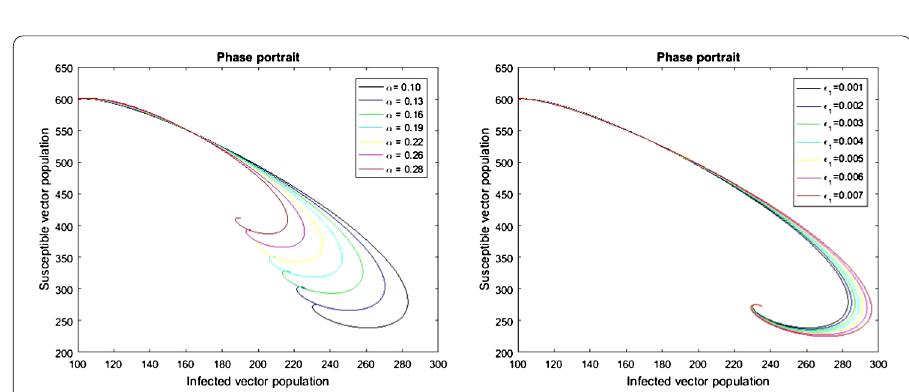
Figure 8 The plots show the phase portrait of the susceptible vector population versus the infected vector